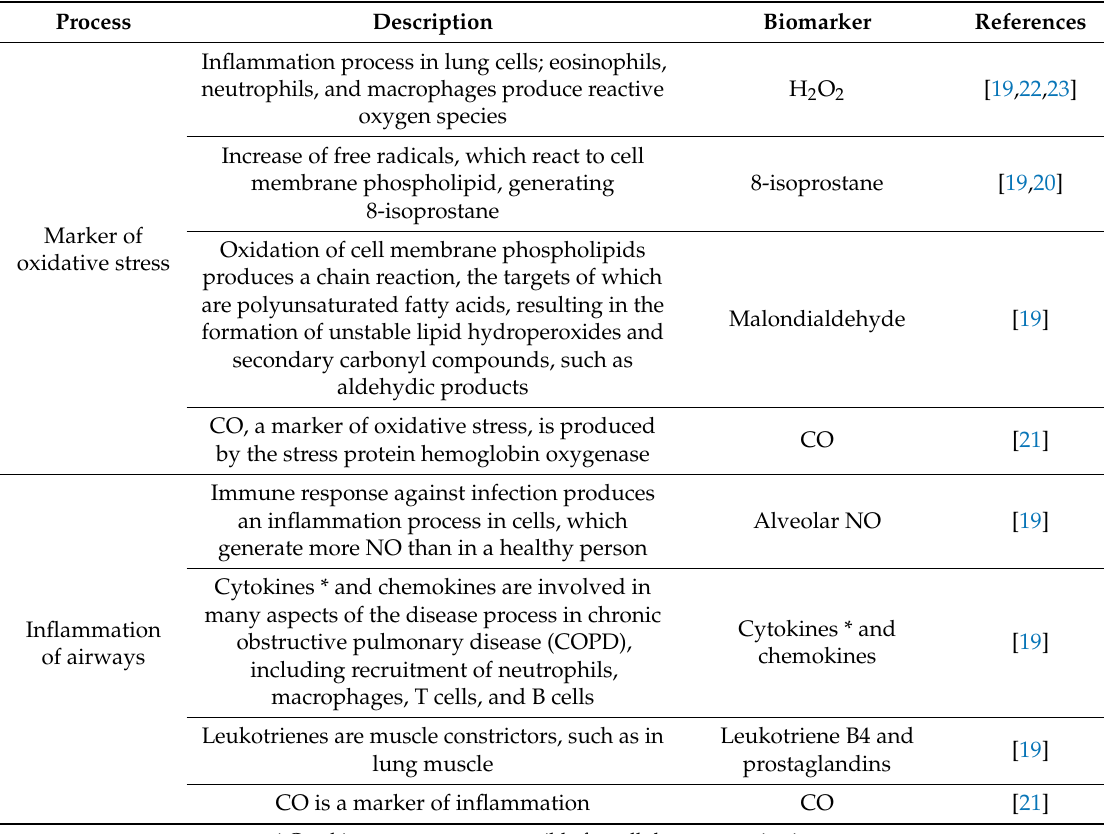
Table 1. Processes involved in different